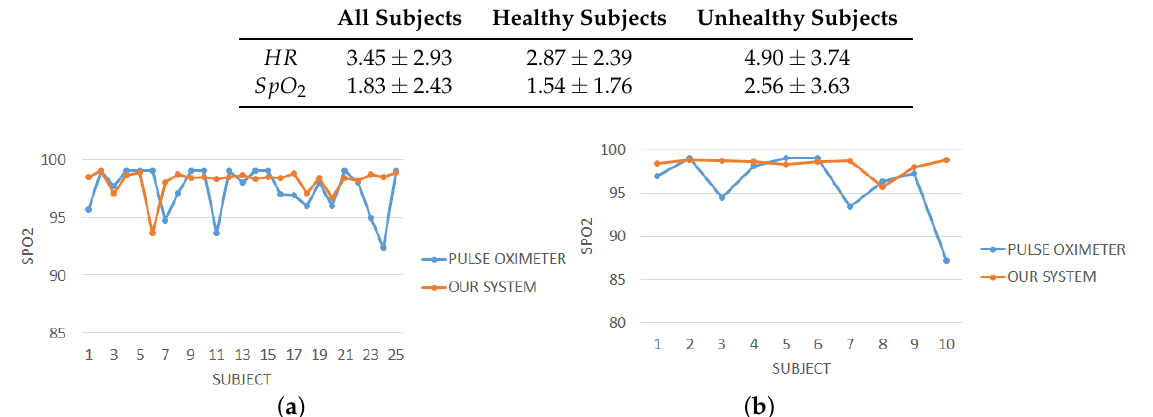
Figure 11. Comparison between SpO 2 measurements computed by our contact-less system and the pulse oximeter for all the 25 healthy subjects ( a ) and for all the 10 subjects suffering from cardiovascular disease ( b